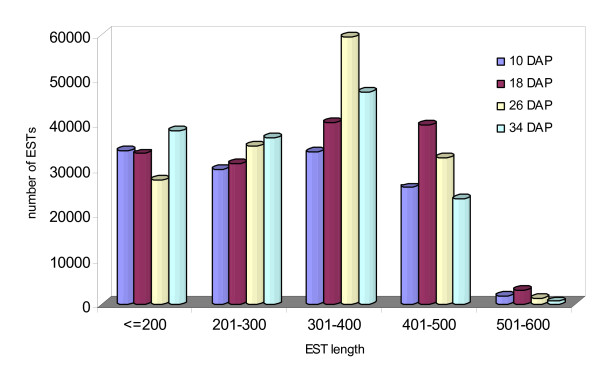
Length distribution of watermelon ESTs.